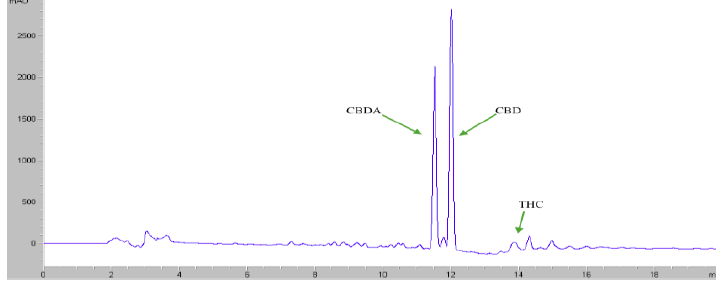
Figure 5. HPLC analysis of a post decarboxylation hemp extract ( x -axis: time in minutes; y -axis: mAU).